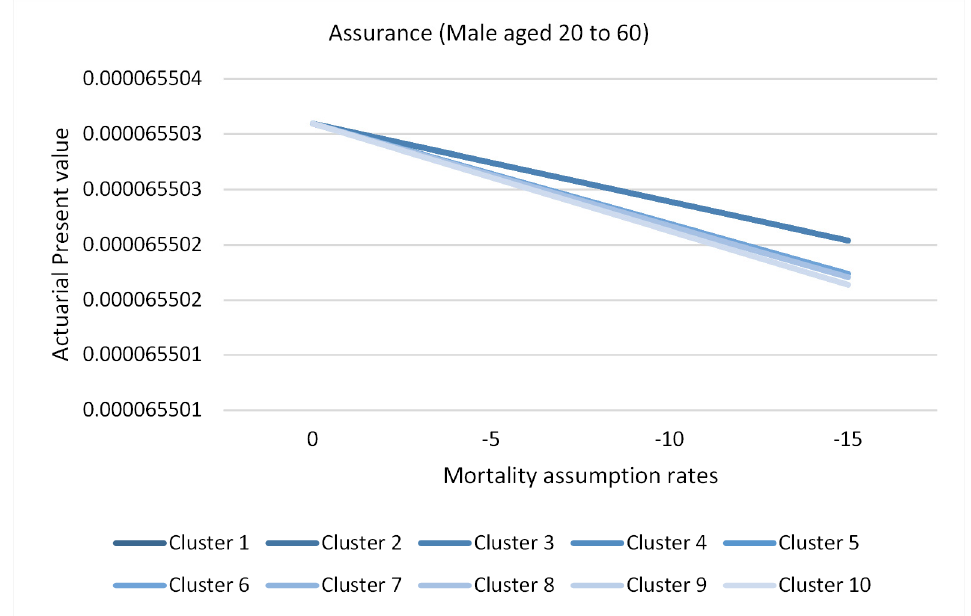
Figure 22. APV for males aged 20 to 60 clusters against mortality assumption rates.